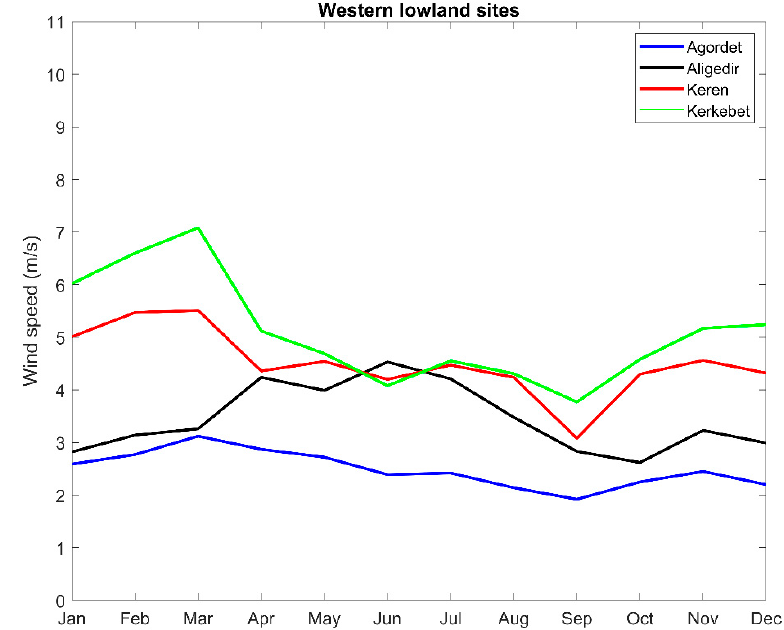
Figure 5. Mean wind speed per month for the year 2000 for the western lowland sites.